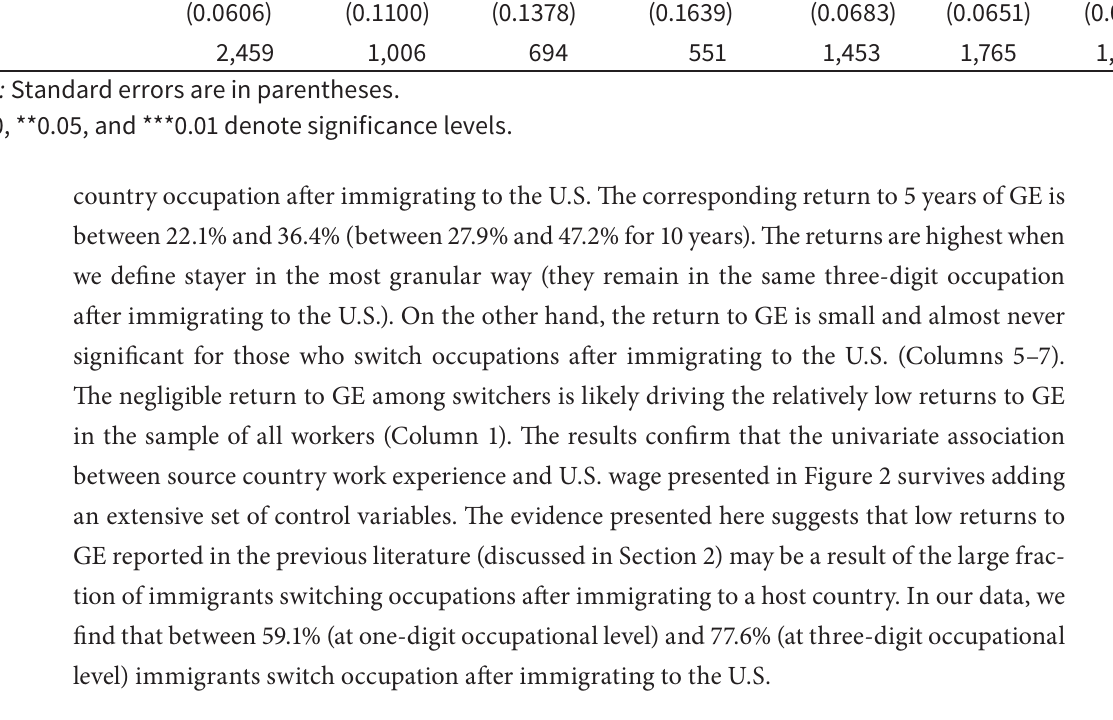
country occupation after immigrating to the U.S. The corresponding return to 5 years of GE is between 22.1% and 36.4% (between 27.9% and 47.2% for 10 years). The returns are highest when